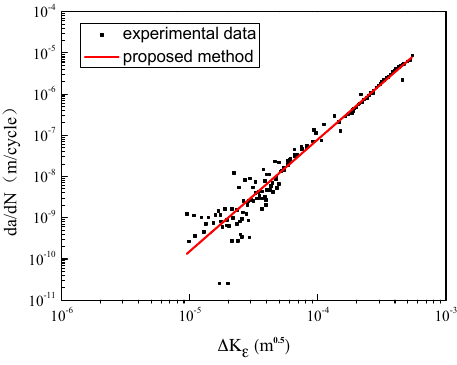
Figure 10. Crack growth rate of 316 stainless steel.